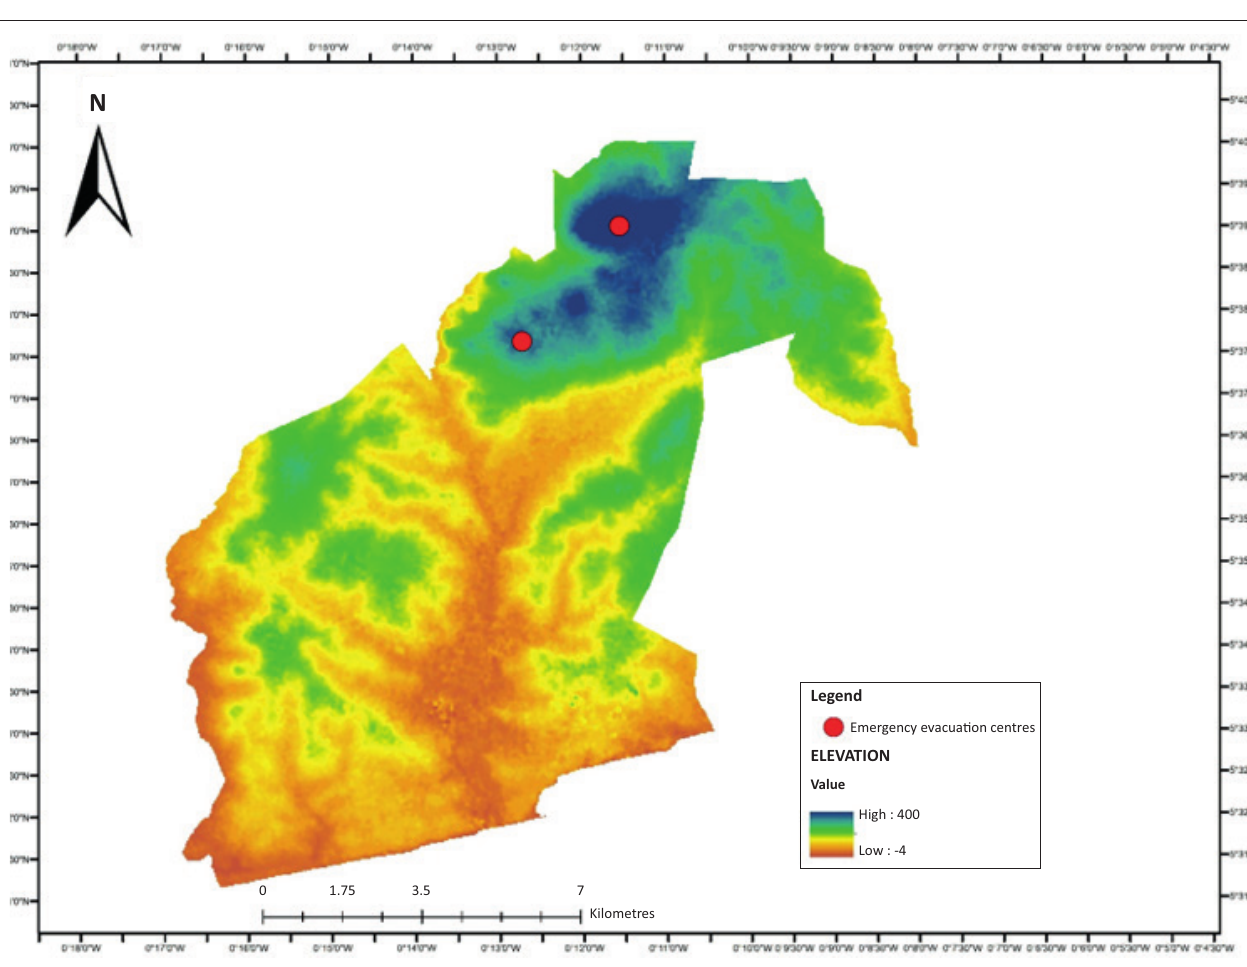
FIGURE 2: Evacuation